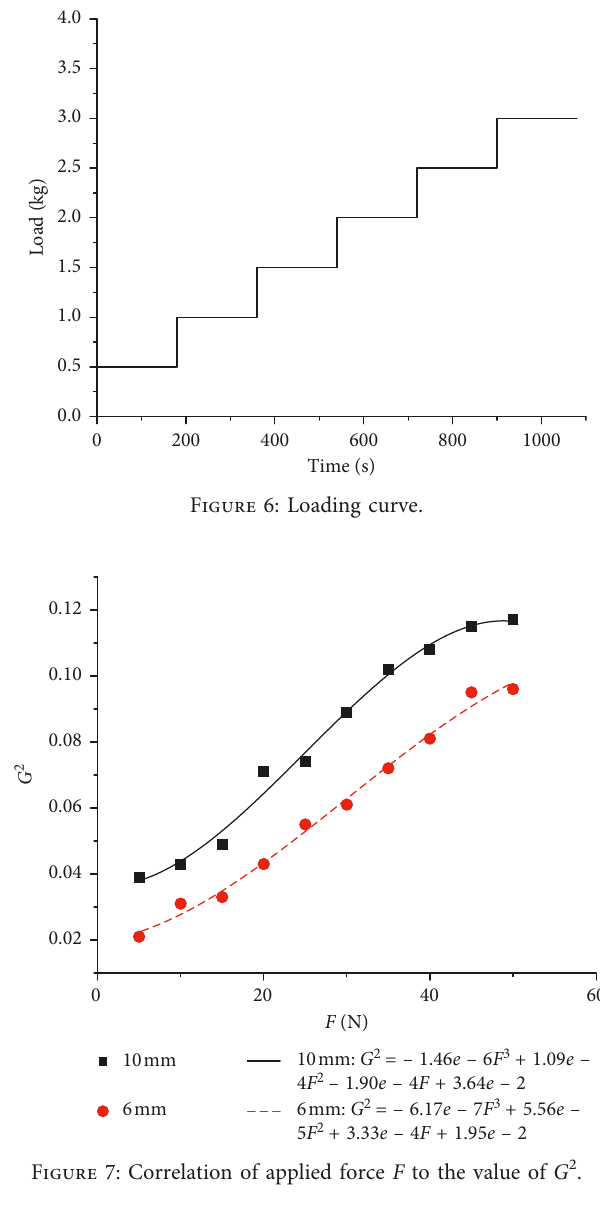
Figure 7: Correlation of applied force F to the value of G 2